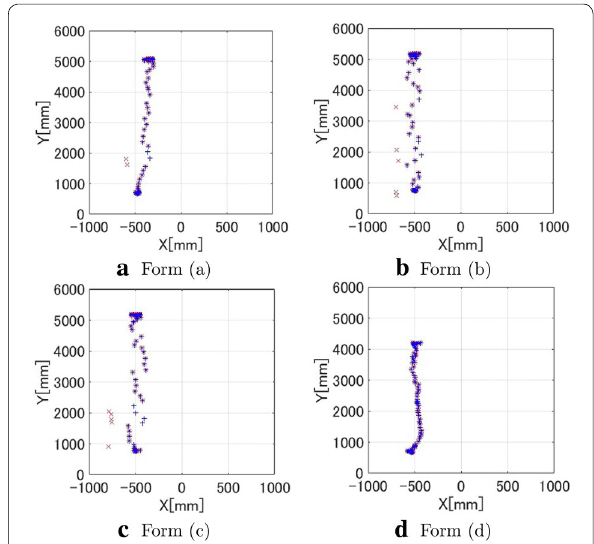
Fig. 20 Estimated trajectories for different walking forms Table 5 Misdetection rates of person